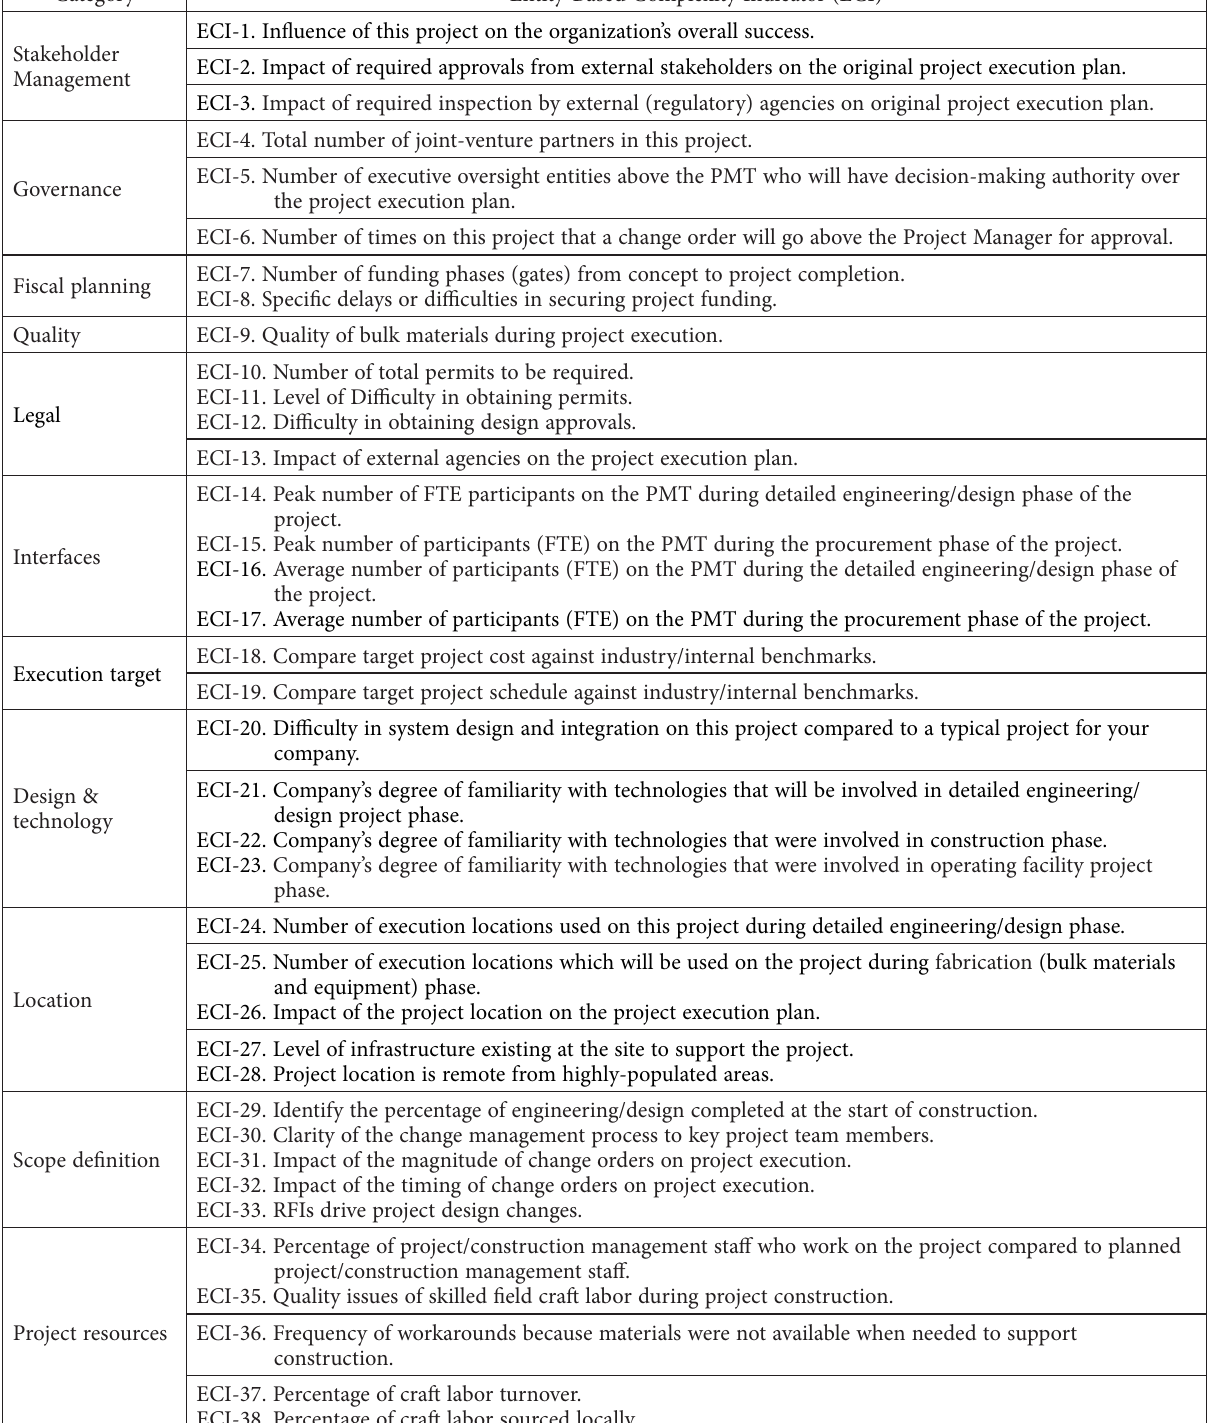
Table 2. Complexity categories and